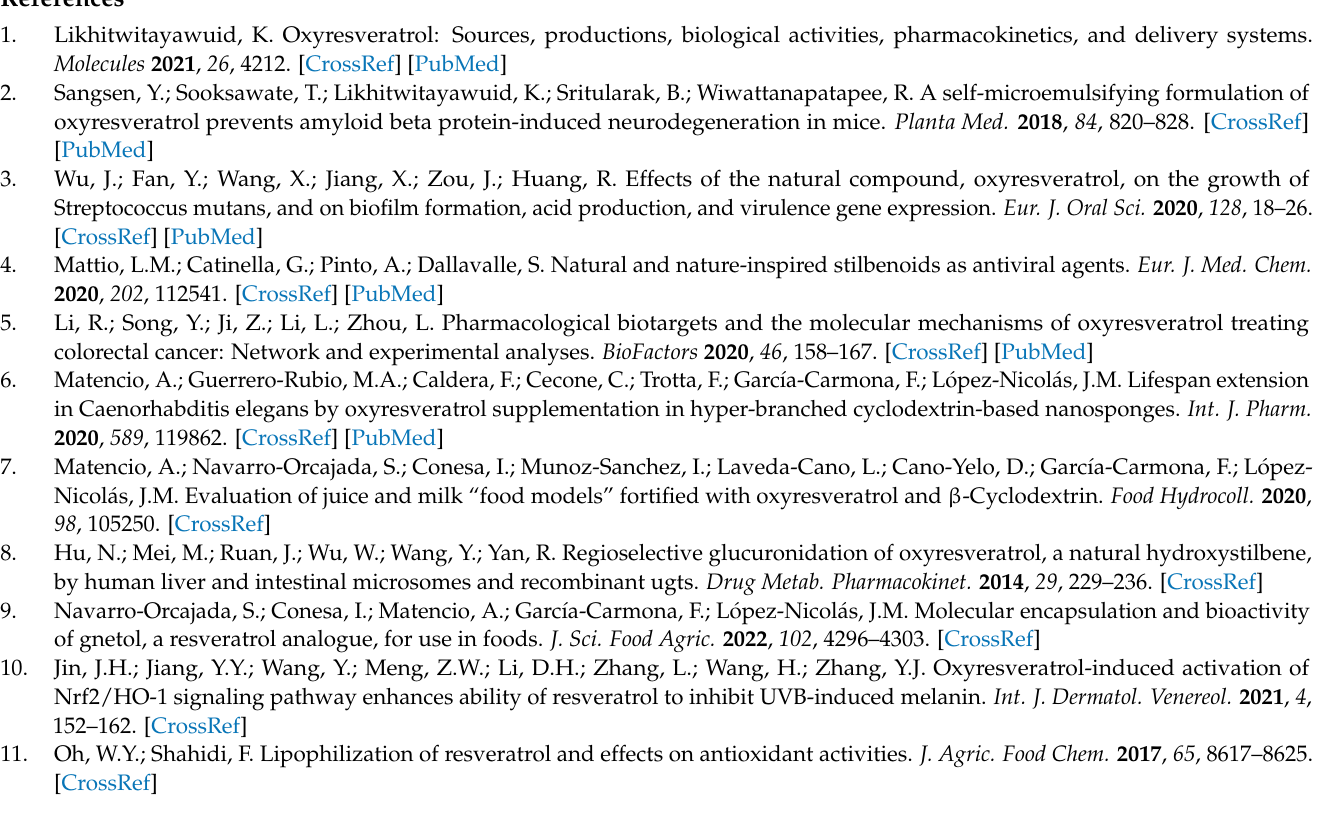
Figure S3: Ultra Performance Liquid Chromatography-Mass Spectrometry